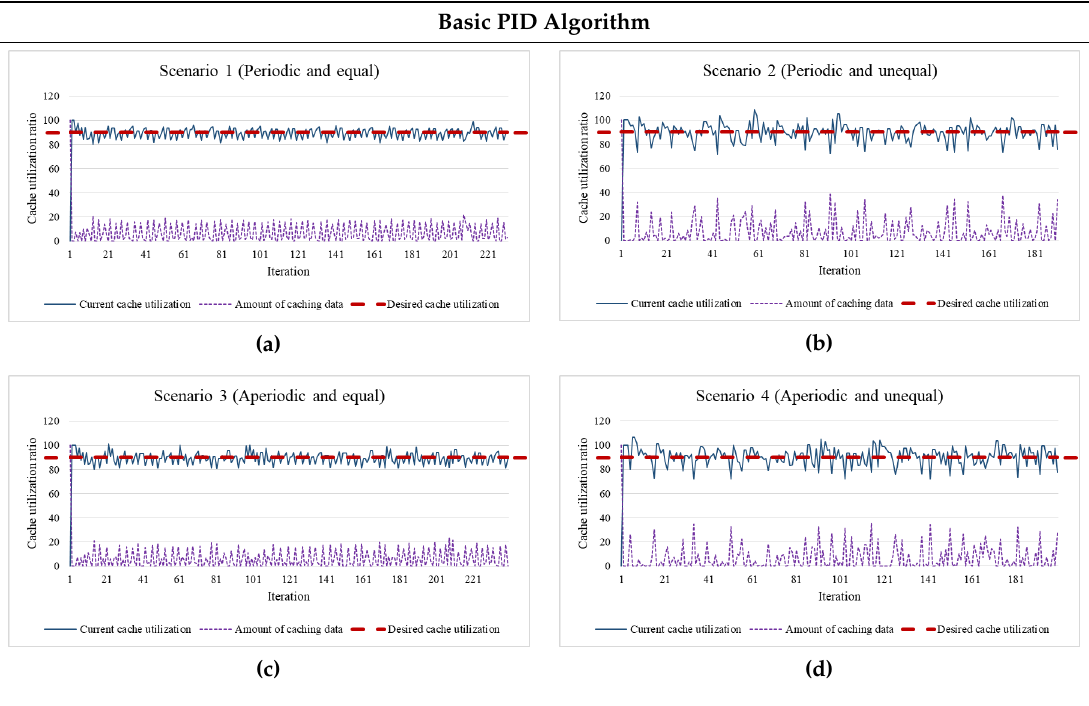
Table 3. Representative performance evaluation results of basic PID